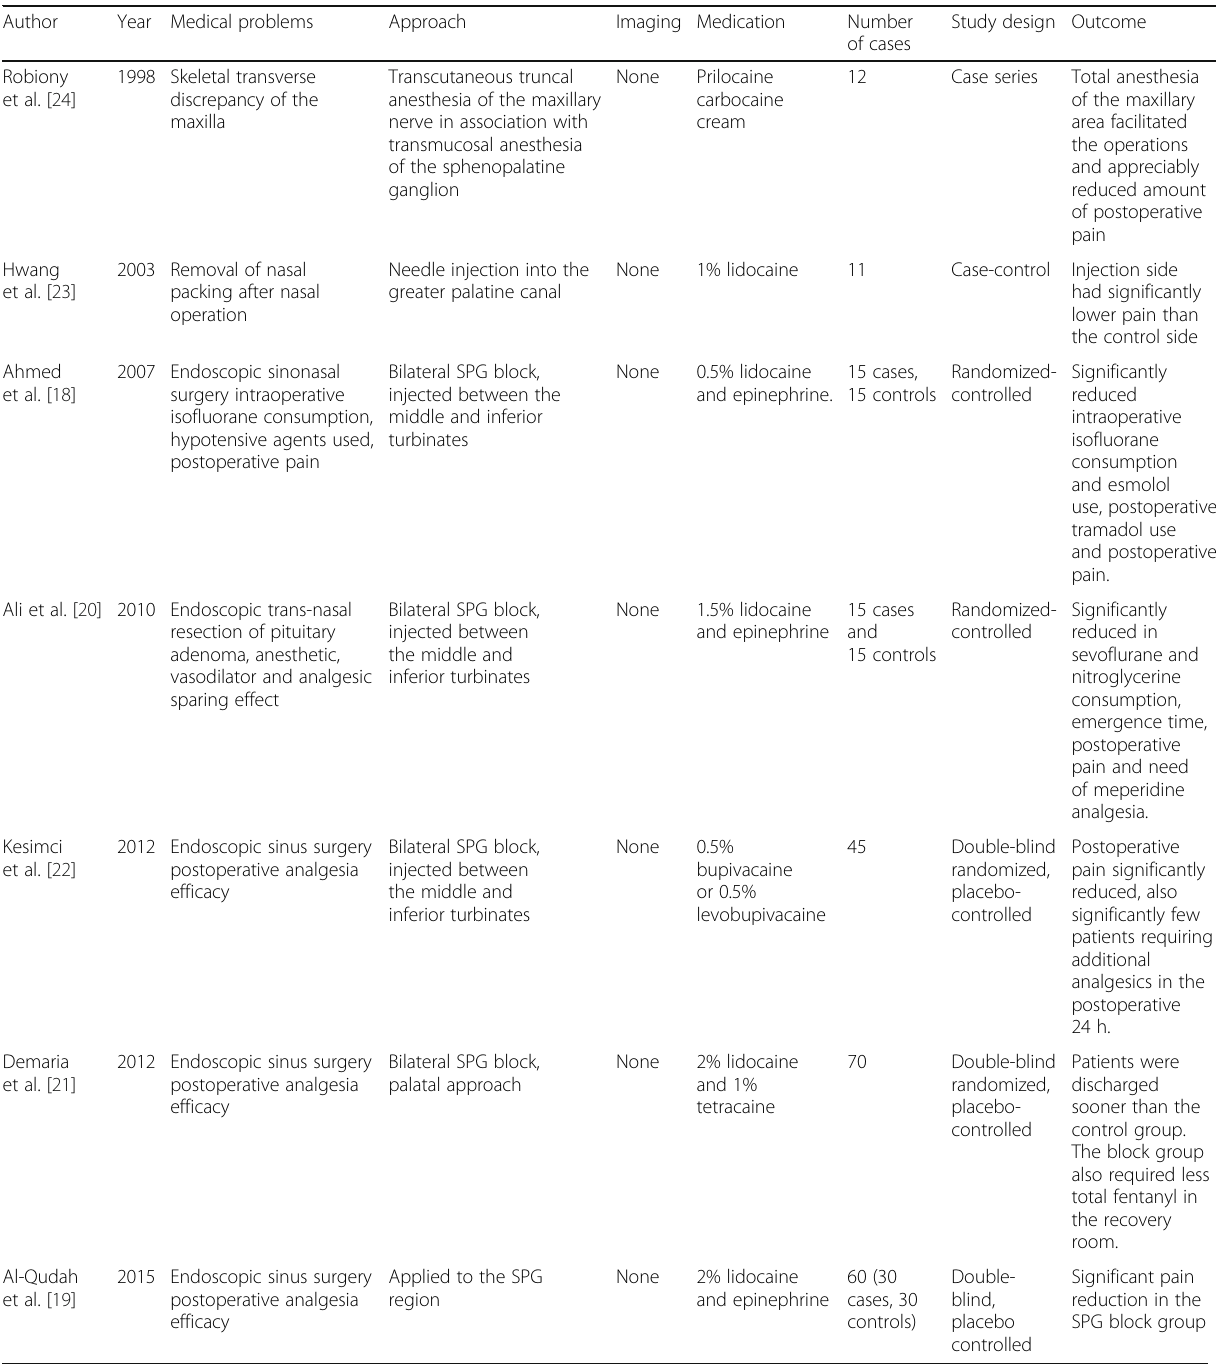
Table 6 Studies of SPG blocks for operative pain of the head and face Operative Pain of the head and